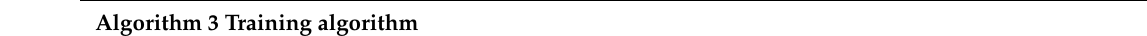
Algorithm 3 Training